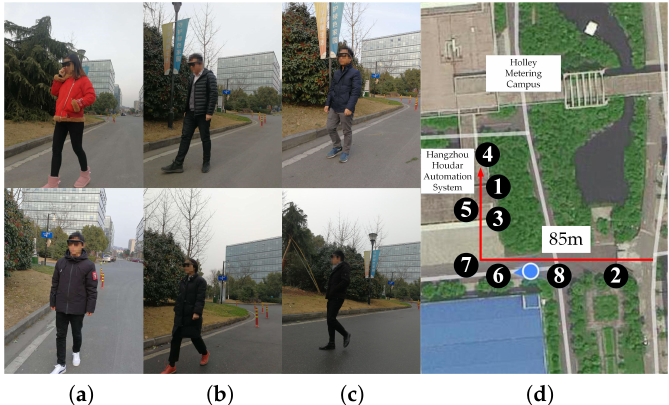
Figure 10. The moments of the field test. ( a – c ) Participants’ faces are blurred for the protection of their privacy. We have obtained approval to use the navigation assistance results for research work. ( d ) The field test around the campus with several locations marked corresponding to Figure 11.